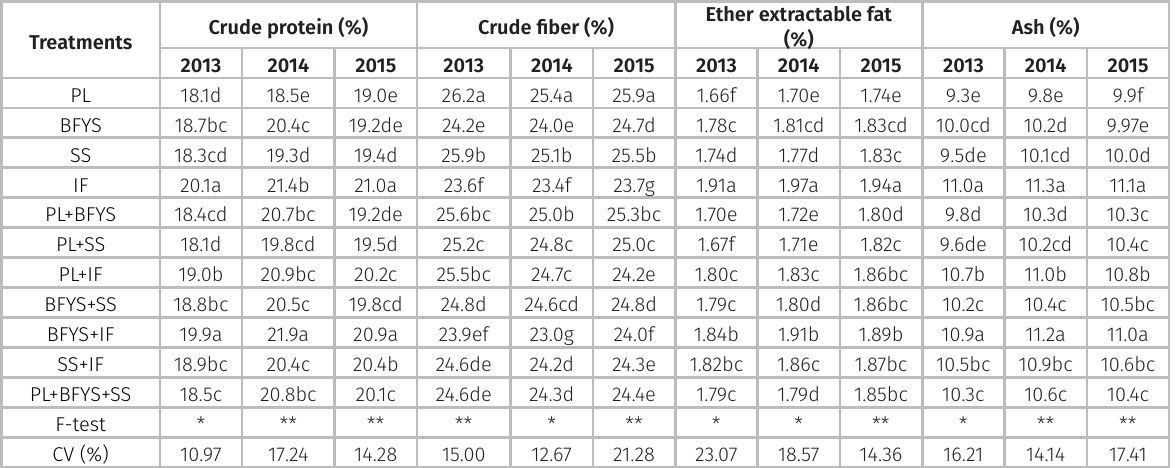
Table VI. Nutritional quality of forage soybean as influenced by different mineral and organic fertilization regimes under irrigated conditions of Faisalabad, Pakistan.